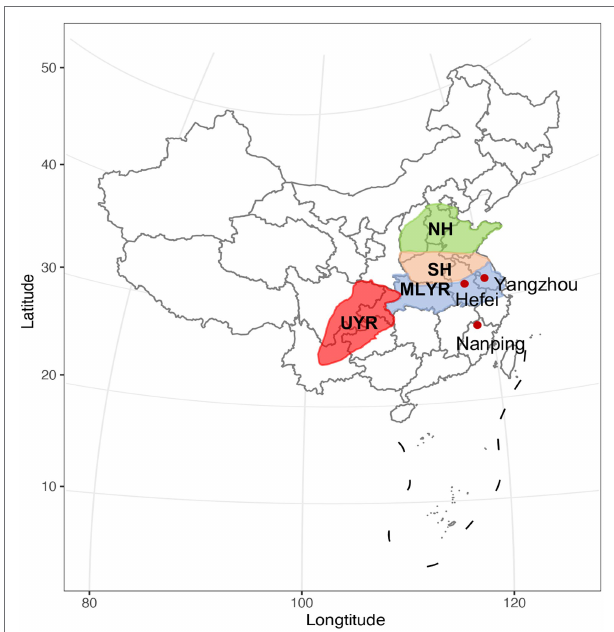
FIGURE 1 | The four ecological regions of wheat production in China. UYR, the upper reaches of Yangtze River Region; MLYR, the middle and lower reaches of Yangtze River Region; SH, the south of the Huanghuai Region; NH, the north of the Huanghuai Region. The three nurseries are indicated with red